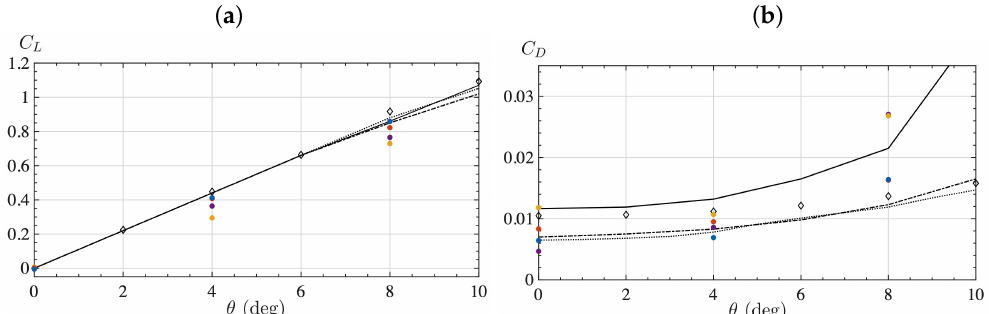
Figure 9. Lift ( a ) and drag ( b ) coefficient of a NACA0012 foil, as a function of its angle of attack. pLBM simulation results, calculated at Re = 1.44 × 10 6 , are plotted as dots, for minimum Grid 3 resolution ( ∆ x / C ) of: 4.0 × 10 − 3 ( • ) ,3.5 × 10 − 3 ( • ) ,3.0 × 10 − 3 ( • ) ,2.5 × 10 − 3 ( • ) . Xfoil simulation results are plotted as black diamonds ( (cid:5) ), the measurements of [43] for Re = 1.44 × 10 6 for a rough foil ( — ), and smooth foil (- - -), and the measurements of [44] at Re = 1.36 × 10 6 for a smooth foil ( – - –